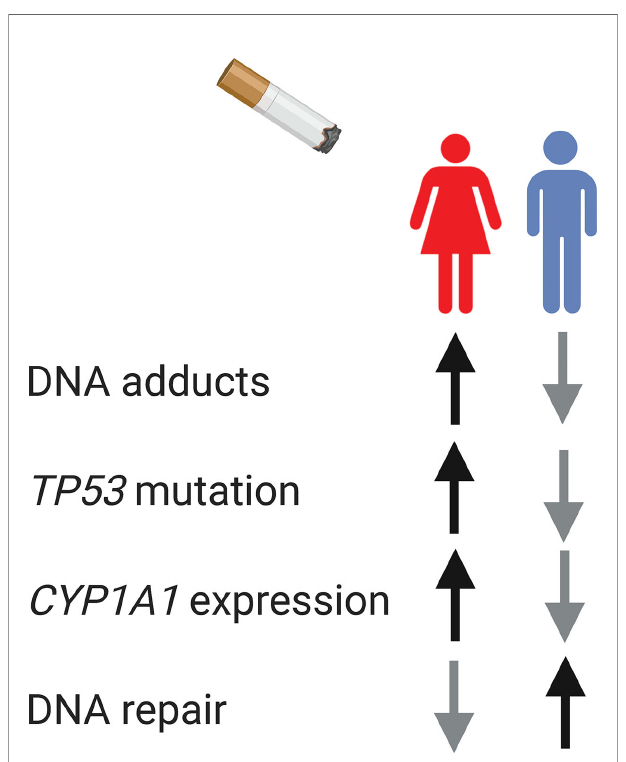
FIGURE 3 | The interplay between sex, gender, and genomics. Biological sex and gender-in fl uenced behavior, such as smoking, in fl uence cancer genomics. In smoking-associated lung cancer, female lung tissue present higher level of DNA adducts, higher TP53 mutation, higher expression level of the carcinogen-metabolizing enzyme CYP1A1, and less ef fi cient DNA